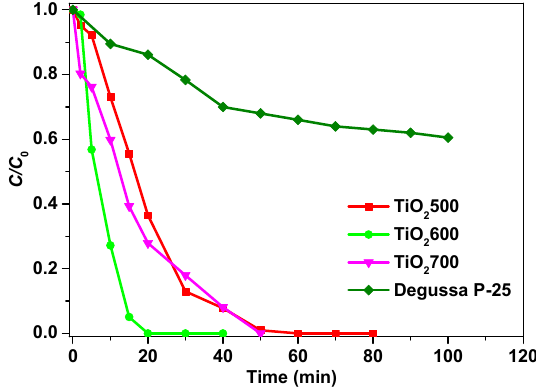
Figure 8. Photocatalytic degradation of RhB dye under UV irradiation.